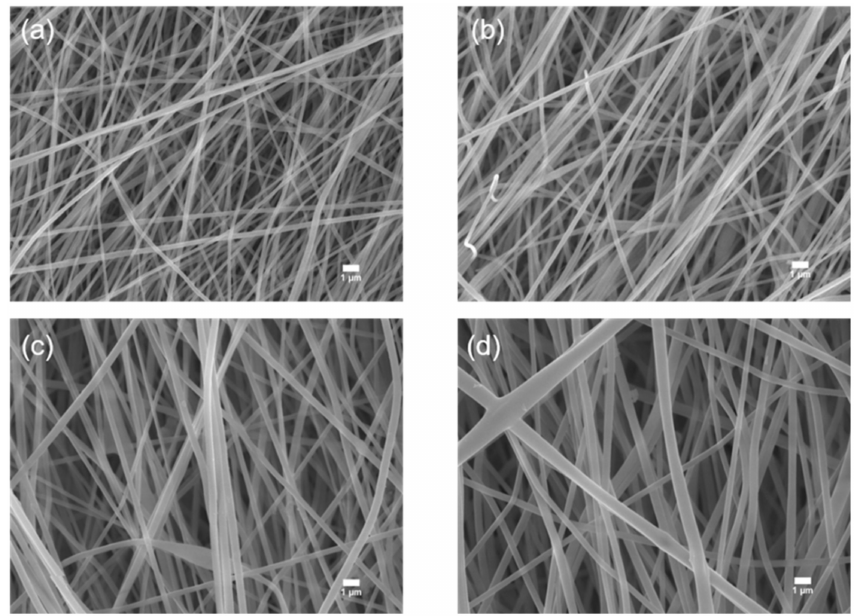
Figure 1. Preparation process of polyacrylonitrile (PAN)–lithium aluminum titanium phosphate (LATP) membranes (PL membranes).